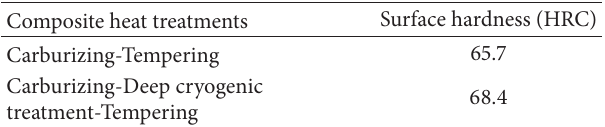
Table 2: Surface hardness of SCM415 with different composite heat